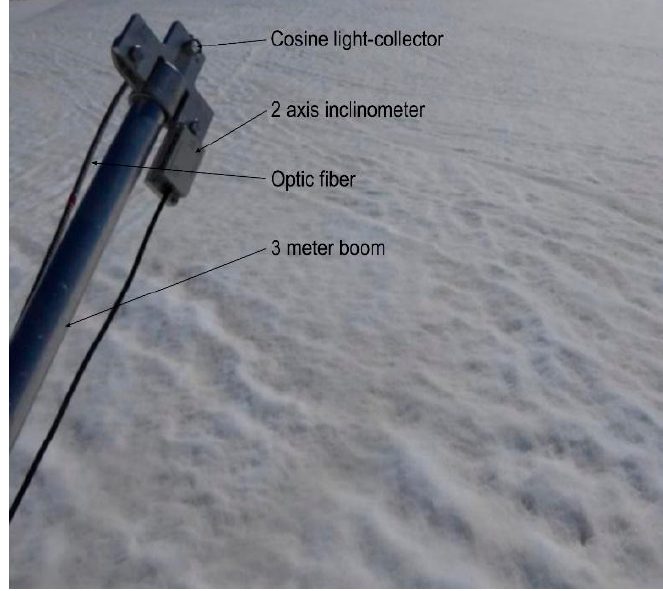
Figure 12. The Solalb light collector shown over a polluted snowpack at Col du Lautaret, French Alps.